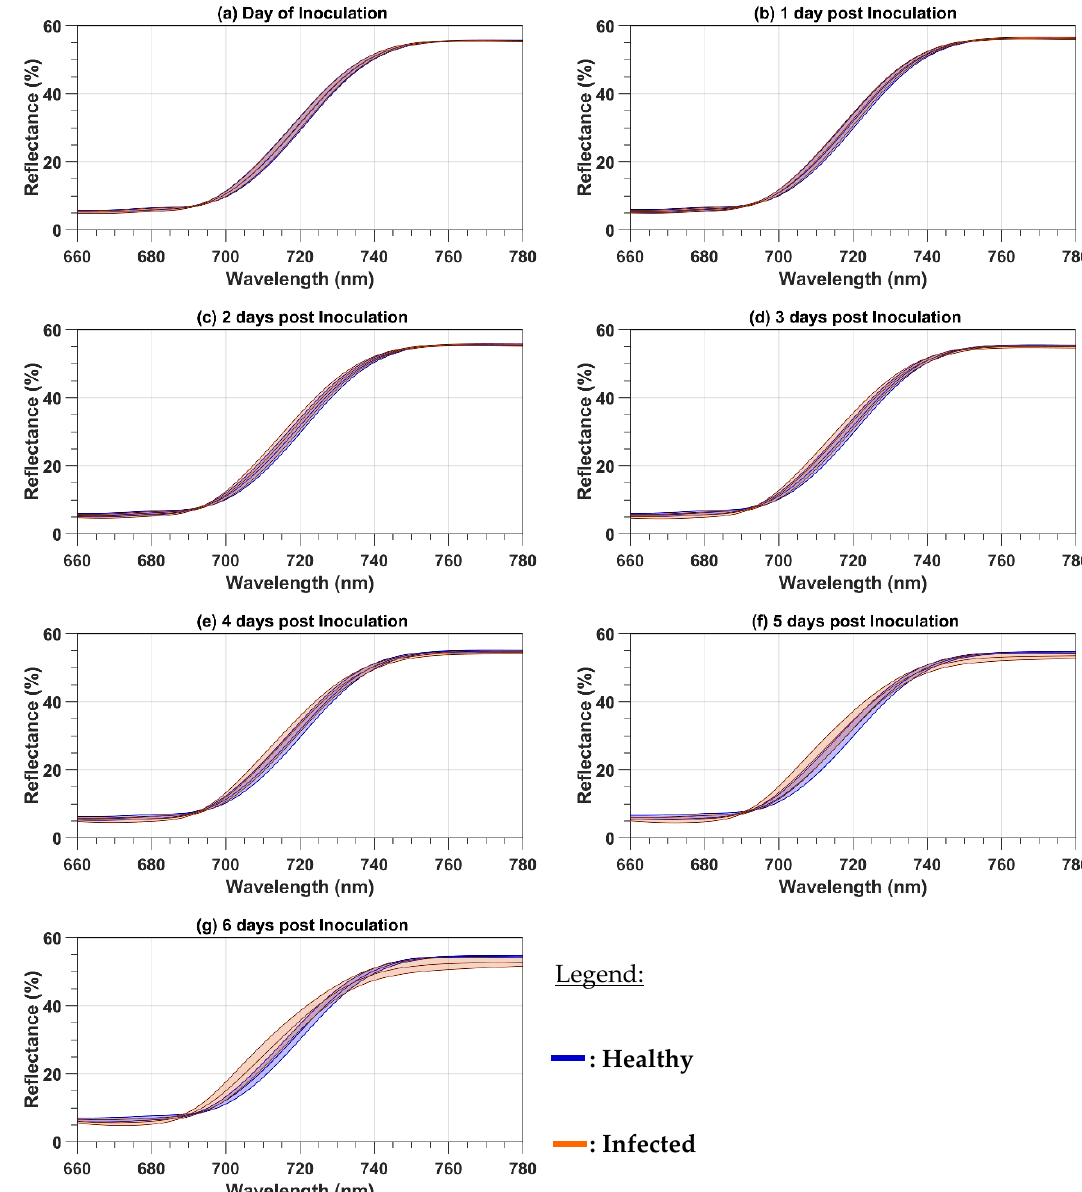
Figure 3. Comparison between healthy and infected leaves for the mean reflectance spectra (with one standard deviation) in the red region (660 to 680 nm) and red-edge region (680 to 780 nm) as a function of the number of days post-inoculation ( a – g).